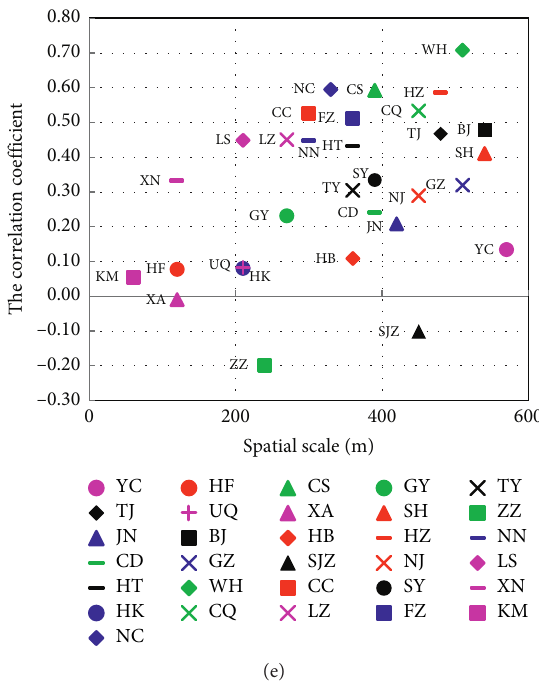
Figure 5: The threshold of spatial scale under the maximum correlation coefficient between the 3D building morphology parameters and the relative UHI intensity. (a) Area; (b) quantity; (c) surface area; (d) volume; (e)